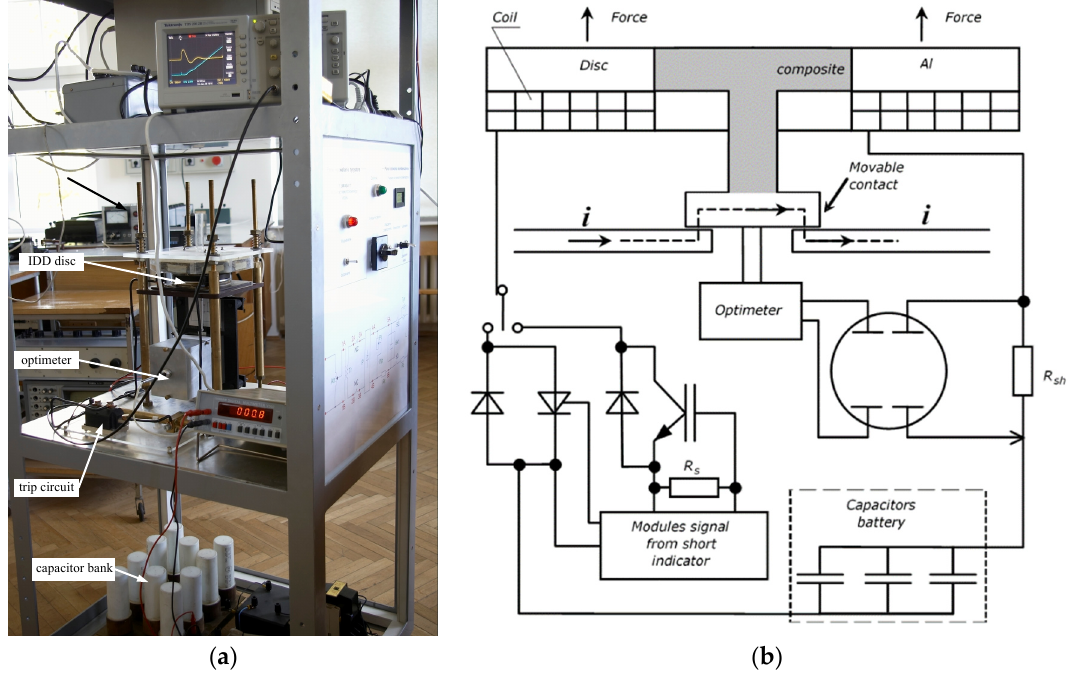
Figure 2. A photo ( a ) and scheme ( b ) of a measuring system for testing physical models of electrodynamic drives.